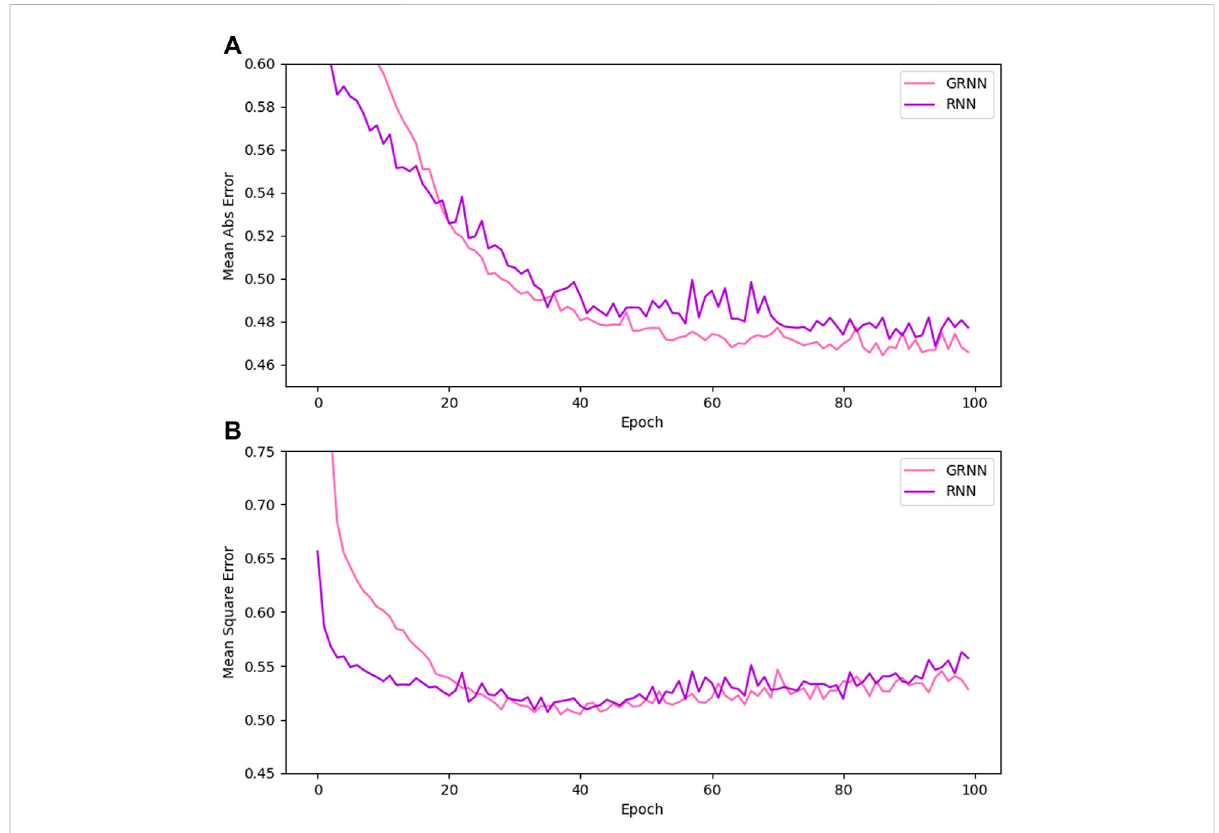
FIGURE 8 Comparison of prediction errors of GRNN and RNN for well B during iteration. (A) MAE, (B)